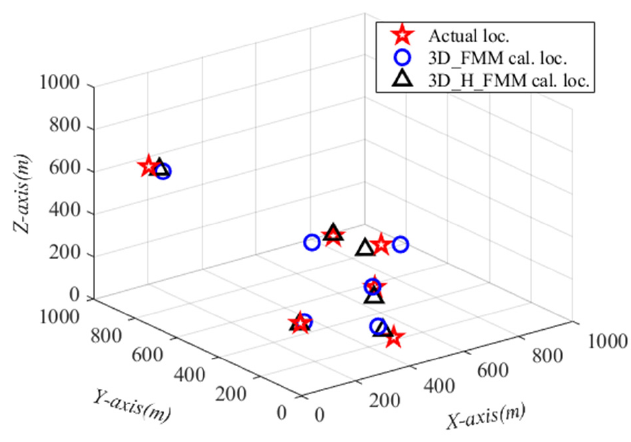
Figure 15. The localization results of microseismic sources with Case D: large-scaled inhomogeneous velocity model.